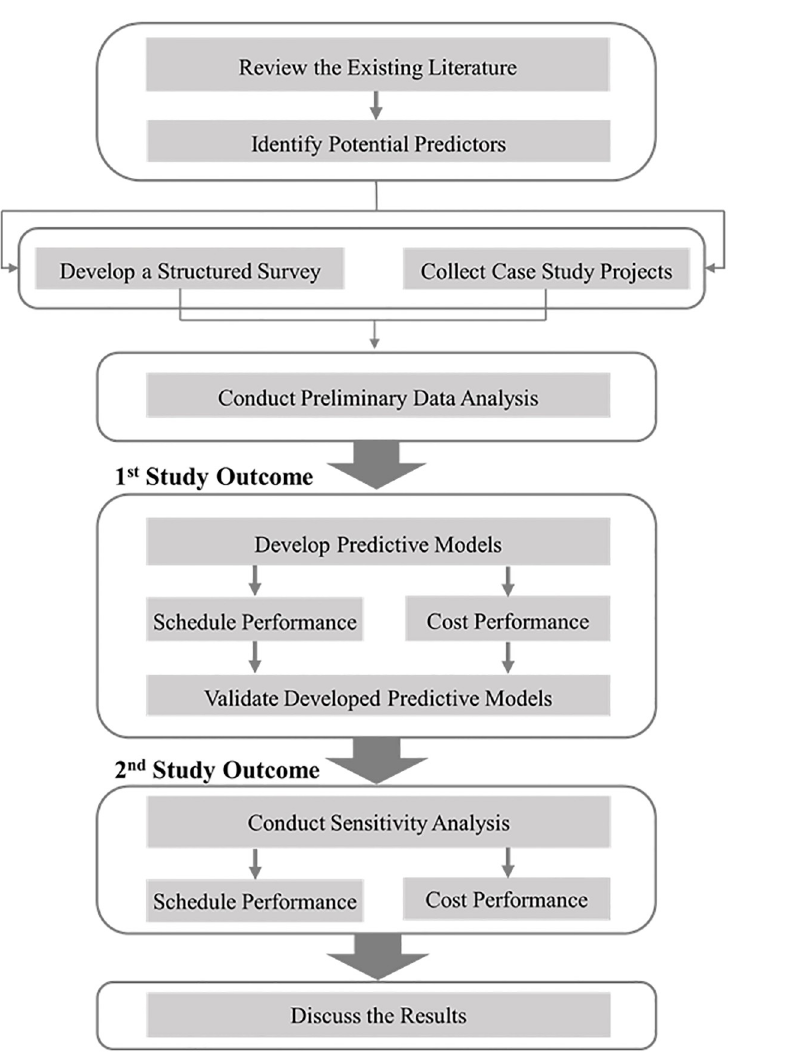
Fig 1. Overview of the study